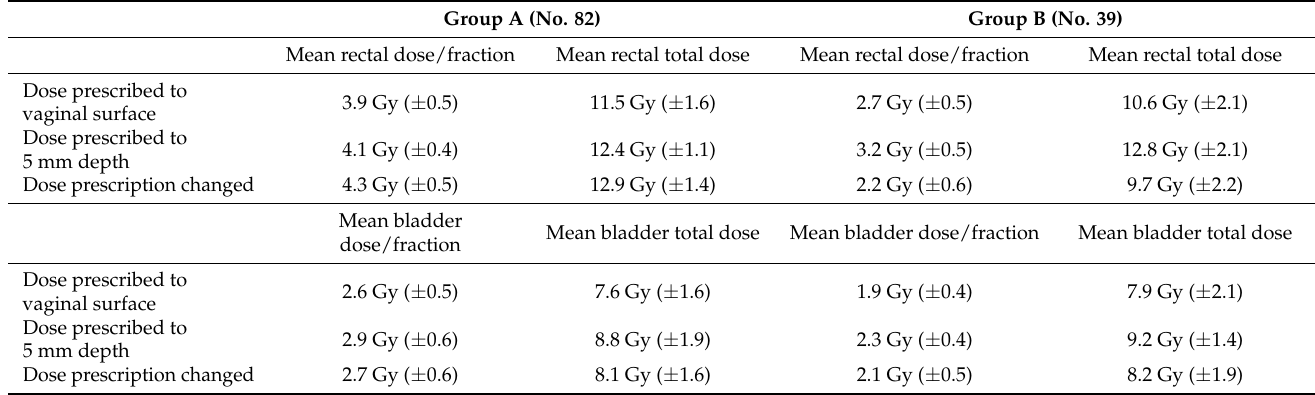
Table 3. Mean rectal and bladder doses between treatment groups.